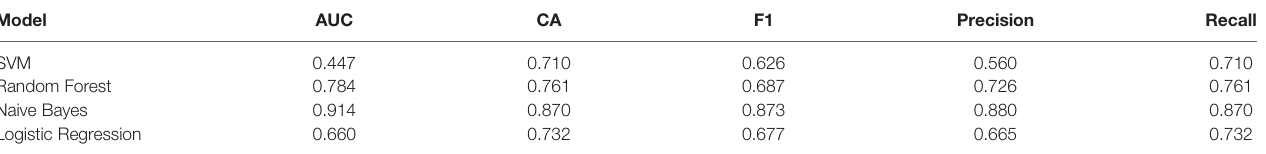
TABLE 2 | Evaluate the model with leave one